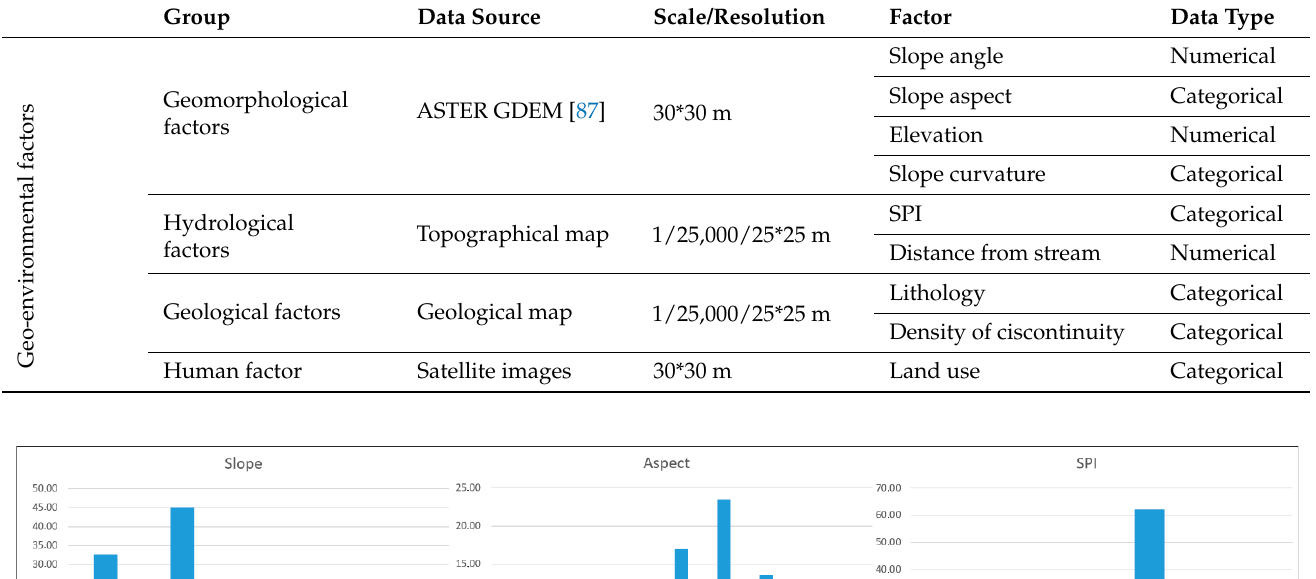
Table 1. Geo-environmental factors used in LSM mapping.